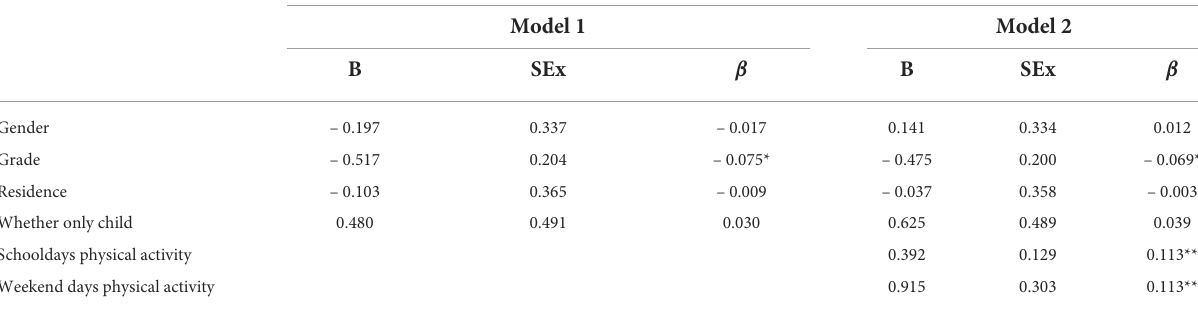
TABLE 4 Regression results of physical activity and life satisfaction ( n =